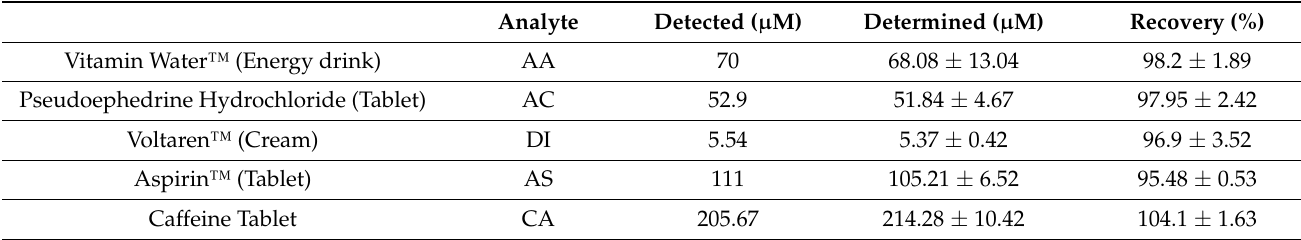
Table 4. Application of GCE-tPANI-Au@Pt-MWCNT for individual determinations of AA, AC, DI, AS and CA in the commercial products ( n = 4, for the reported relative standard deviation (RSD)